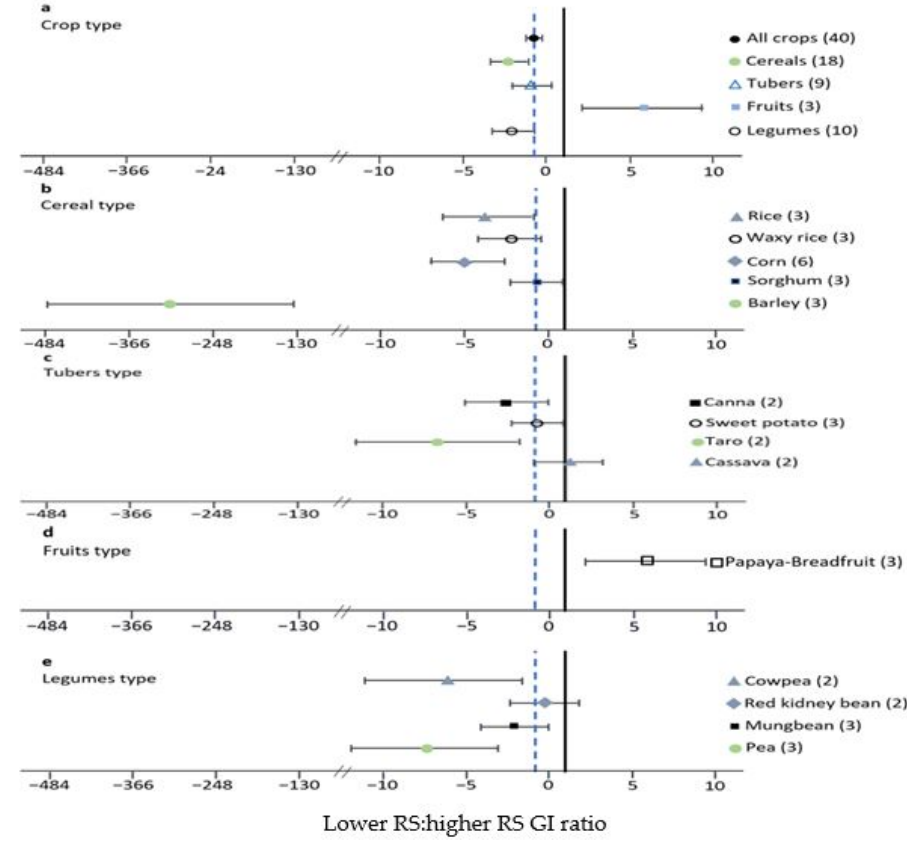
Figure 7. Influence of different crop type ( a ), cereal type ( b ), tuber type ( c ), fruit type ( d ), and legume type ( e ) on lower-RS